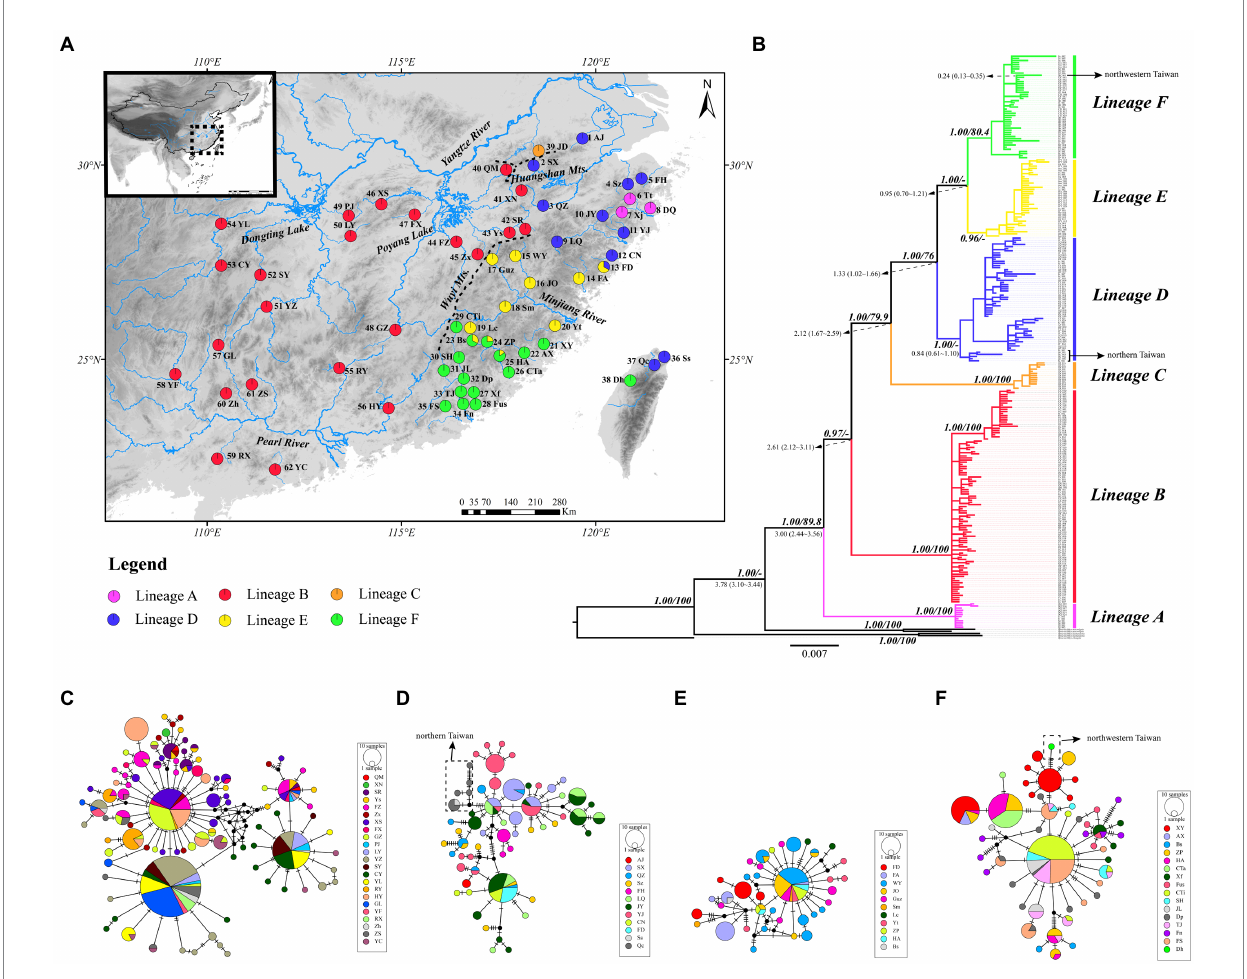
FIGURE 1 (A) Map of sampling localities of the O. acutipinnis-evolans complex. Codes for sampling localities are given in Table 1 and Supplementary Table S1. Populations are present as pie charts with slice size proportional to the frequency of the six major lineages identified by the Cyt b gene tree as in (B) . (B) Cyt b gene tree from Bayesian inference. Numbers in bold and italics at nodes indicate Bayesian posterior probabilities (PP) and bootstrap values (BS) from maximum likelihood analysis, respectively. Only well-supported numbers (PP > 0.95, BS > 70) are shown. Numbers in regular at nodes indicate divergence time estimate of major lineages. Colored branches denote different lineages as in (A) . (C–F) Median-joining (MJ) networks of the O. acutipinnis-evolans complex concerning lineage (B, D-F) . The mutation steps are shown as hatch marks on the branches. Missing (or unsampled) haplotypes are represented by black dots. The area of each circle is proportional to the number of individuals for each haplotypes. Different colors denote different